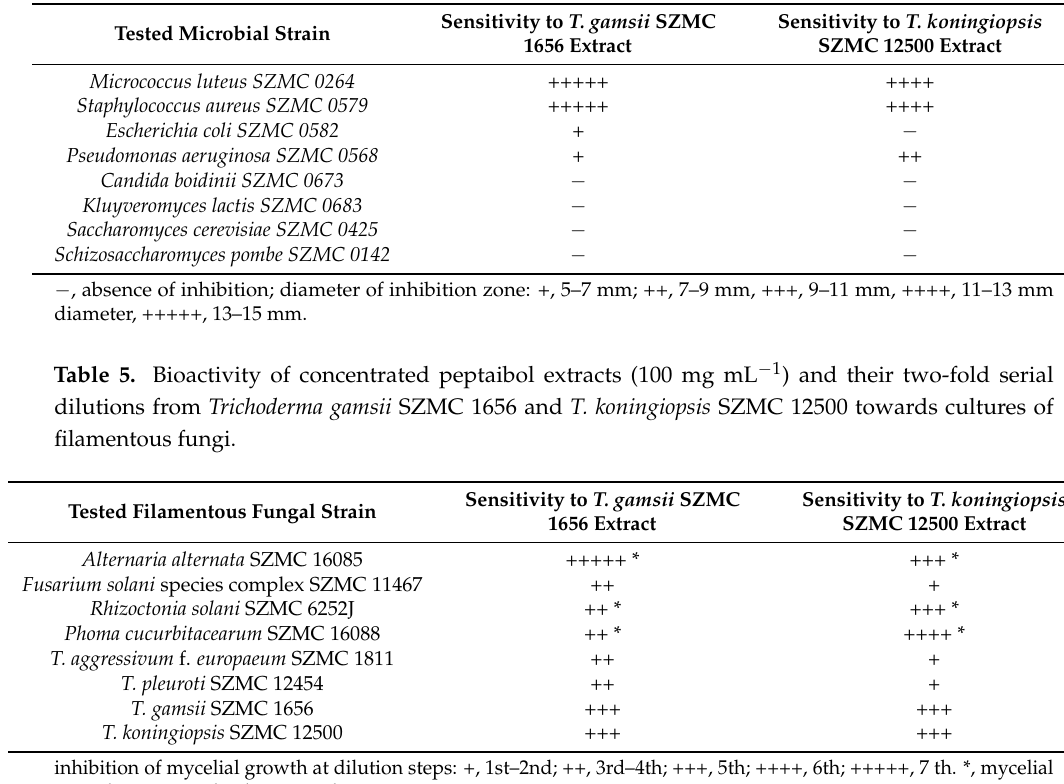
Table 4. Bioactivity of concentrated peptaibol extracts (100 mg mL − 1 ) from Trichoderma gamsii SZMC 1656 and T. koningiopsis SZMC 12500 towards bacteria and yeasts.